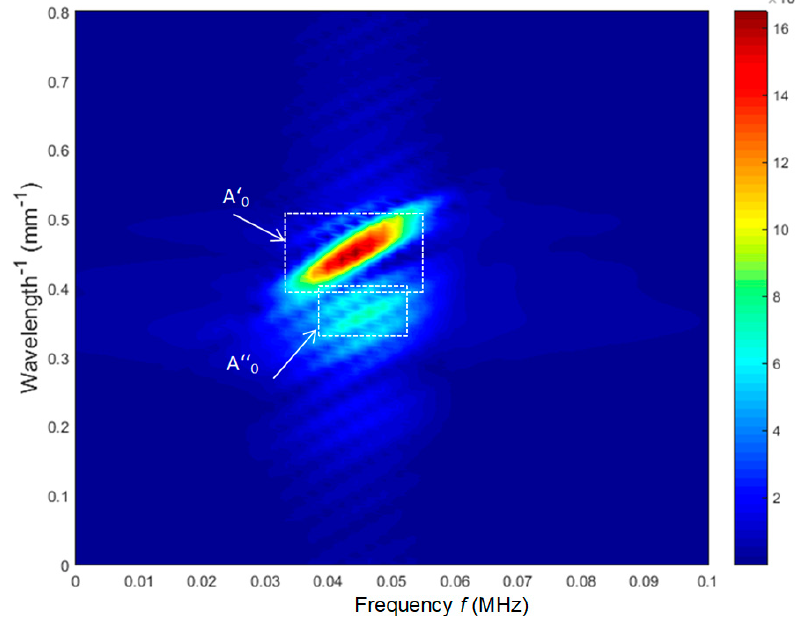
Figure 17. 2D spatial-temporal spectrum of the B-scan modes in the case of a single circular non-uniformity.